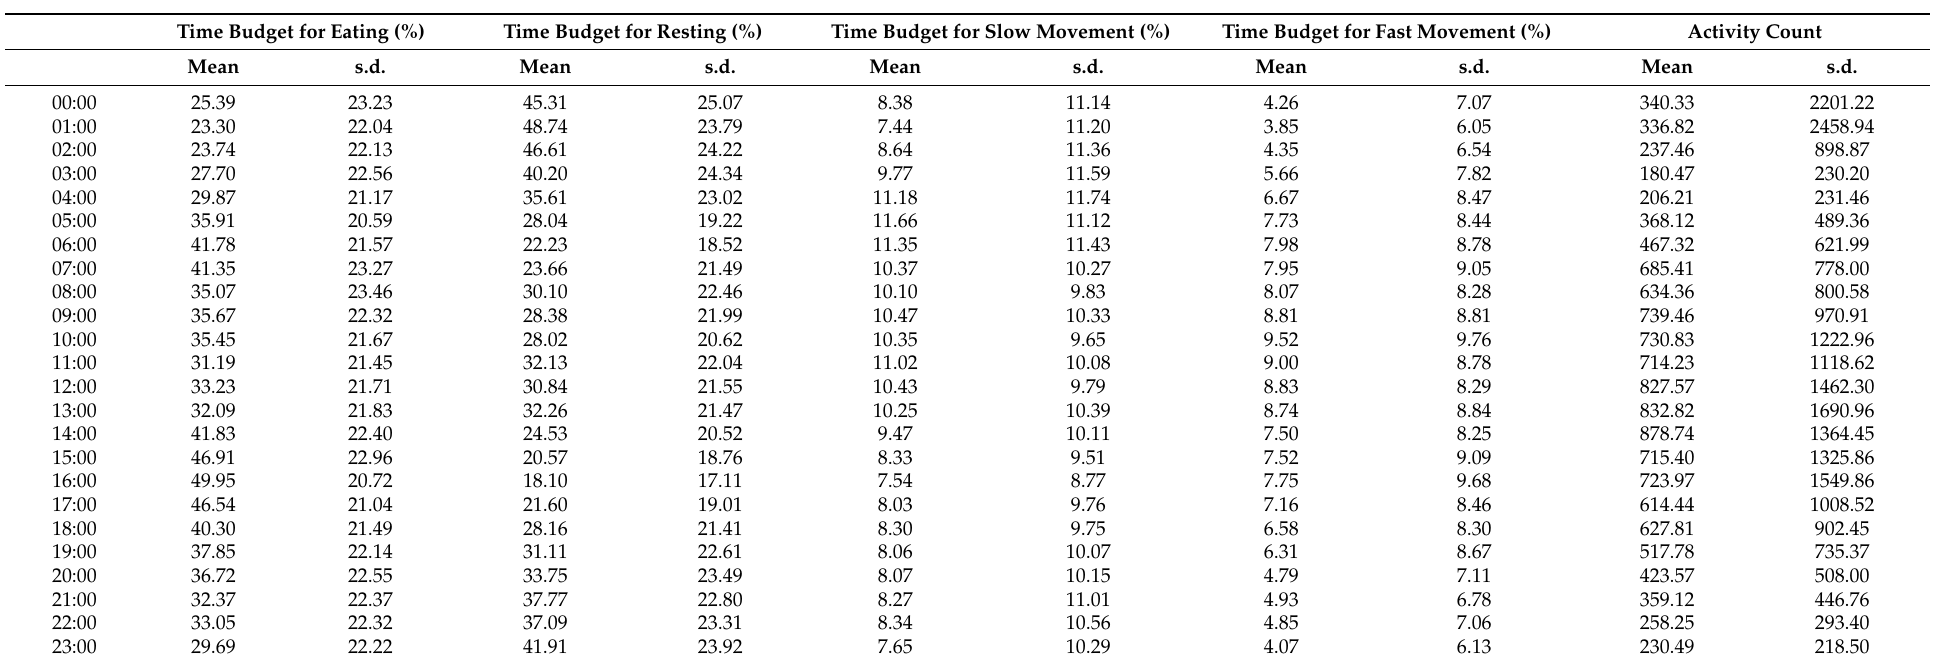
Table 2. Time budgets for eating, resting, slow movement (“active”) and fast movement (“highly active”) and the activity count by time of